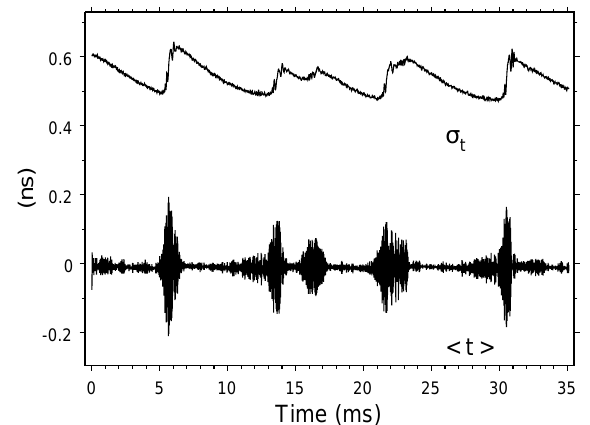
FIG. 6. Bunch time evolution in ELEGANT simulations of SURF. The top plot shows the relaxation oscillations of the rms bunch length, giving a period of 8 ms. The bottom plot shows the average centroid offset relative to the synchronous particle, showing dipole motion occurring during the blowup phase.